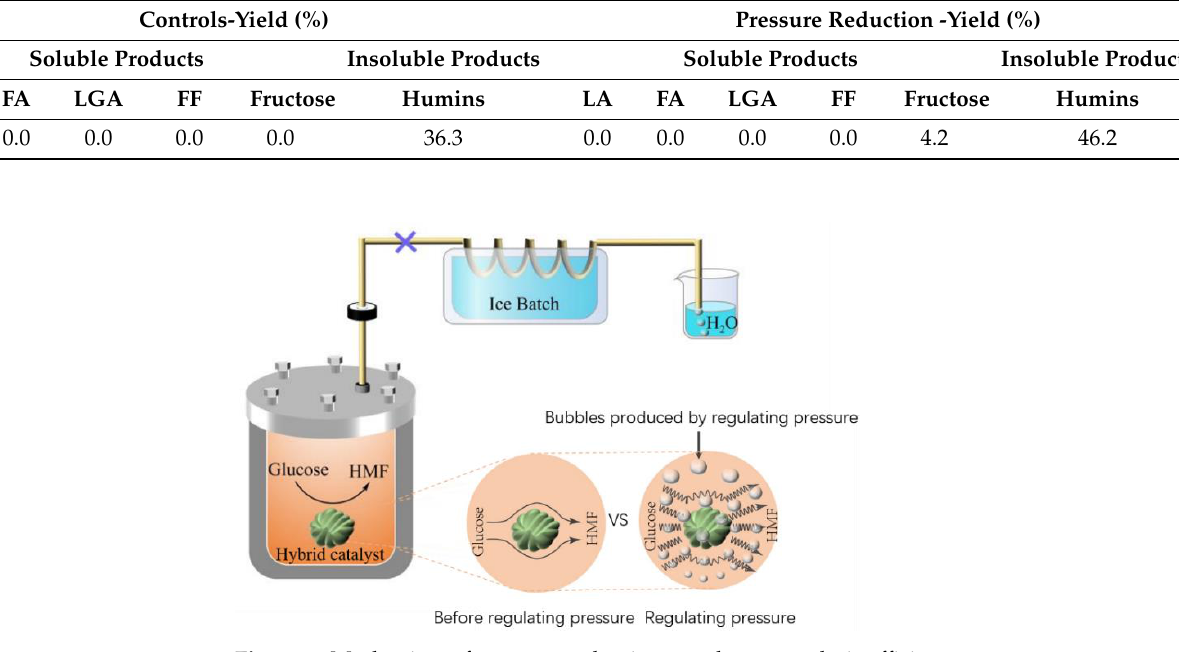
Table 3. The byproducts in the solution at a temperature of 190 °C and time of 60 min.